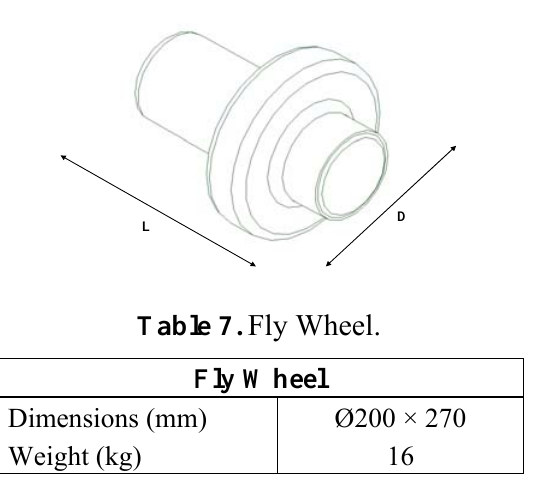
Figure 8. Fly wheel; L = 270 mm, D = 200